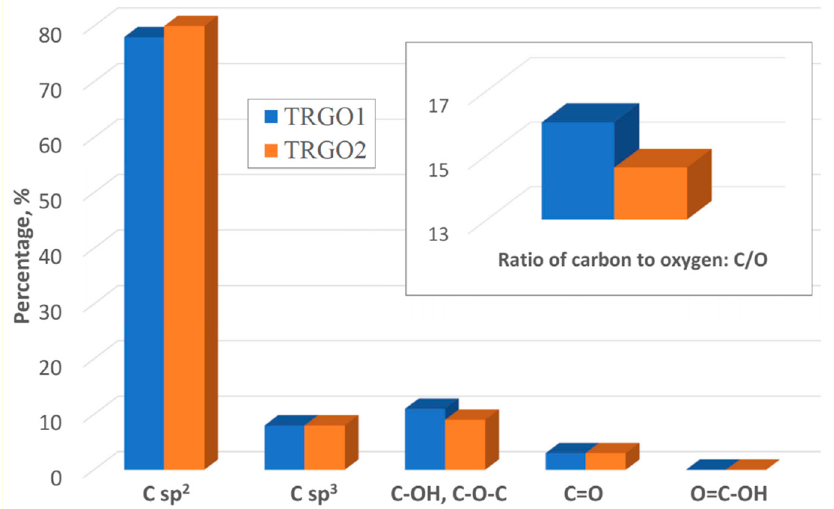
Figure 5. Distribution of carbon and oxygen bonds determined by XPS.